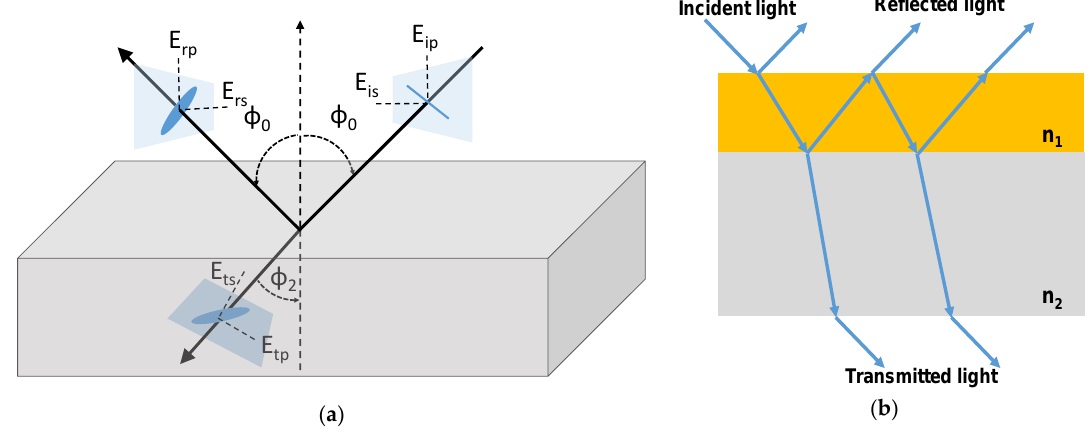
Figure 4. Scheme of spectroscopy ellipsometry measurement for: ( a ) the homogeneous sample; ( b ) the monolayer surface coated sample.